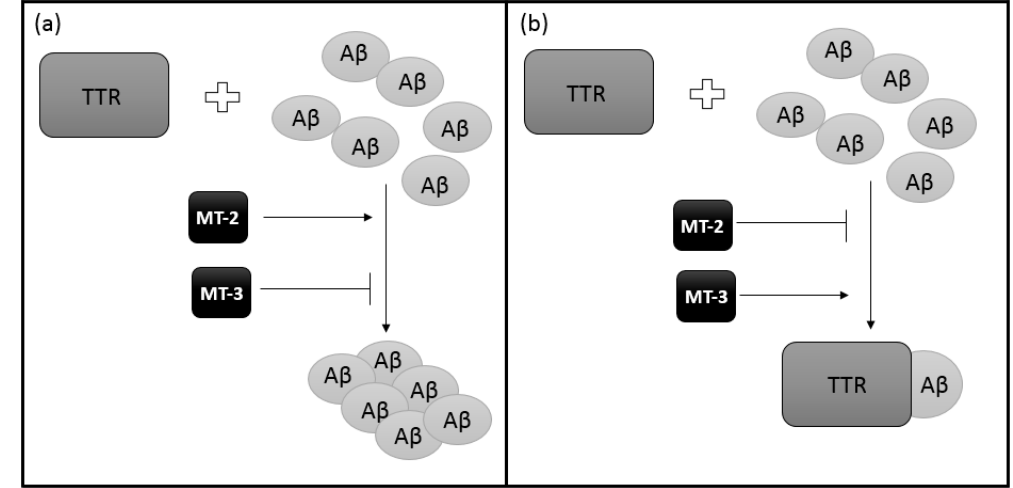
Figure 4. A schematic effect of different MT isoforms on TTR ability of A β binding: ( a ) MT-2 reduces binding interaction between TTR and A β so the removal of A β will be less efficient while ( b ) MT-3